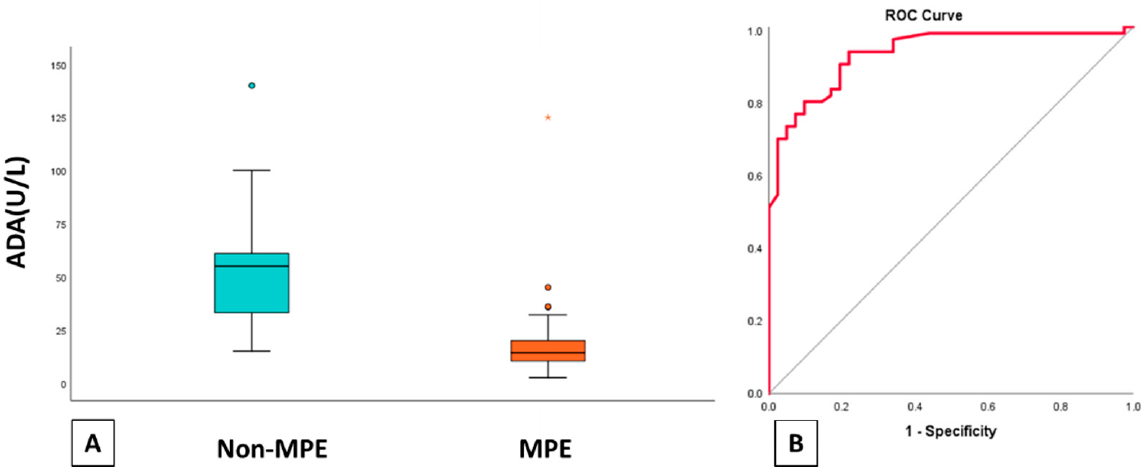
Figure 3. Distribution of patients in CPPE and non- CPPE groups based on a cut-off of pleural CRP ≥ 10 mg/dl. CRP: C-reactive protein, CPPE: complicated parapneumonic pleural effusion. The mean value of the ADA-pleural for patients with a diagnosis of malignant pleurisy is 18.11 U/L, while for patients with another diagnosis of pleural effusion 53.58 U/L. We observe, therefore, that patients diagnosed with malignant pleural effusion have signif- icantly lower ADA values than patients diagnosed with PPE and TPE. The box plot of